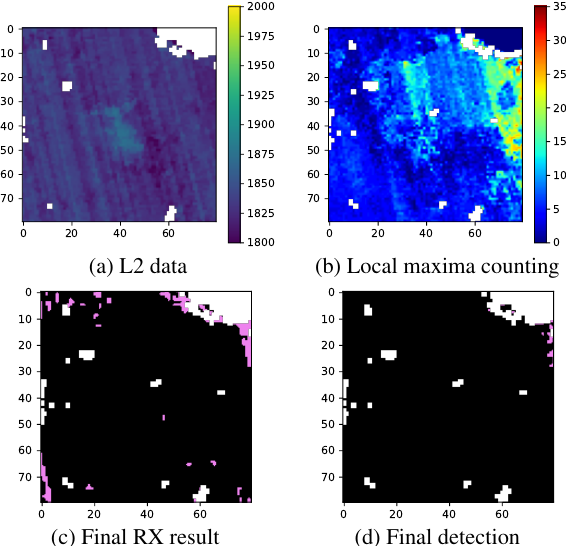
Figure 6. On the top right of (d) we detect a methane plume that cannot be seen in the L2 product. Figures (b) and (c) show that this plume is found with the counting of maxima and with RX.